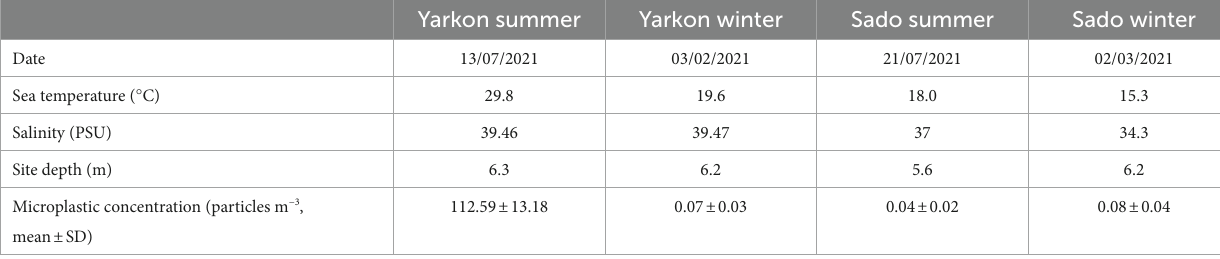
TABLE 1 Environmental parameters and microplastic concentration for each